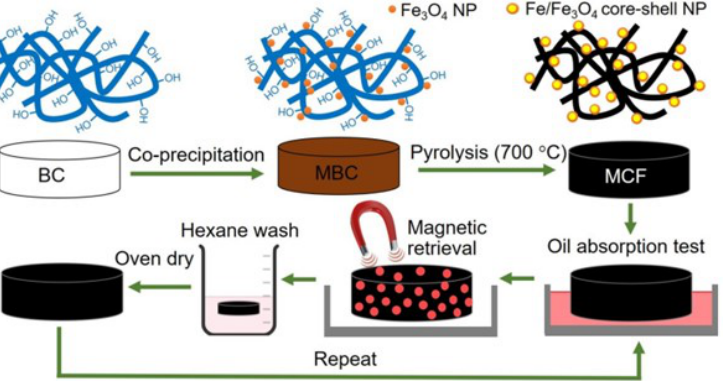
Figure 13. A diagram for the synthesis of magnetic carbon fiber (MCF) aerogels and the oil absorption measurement. Reproduced with permission [165]. Copyright 2020, American Chemical